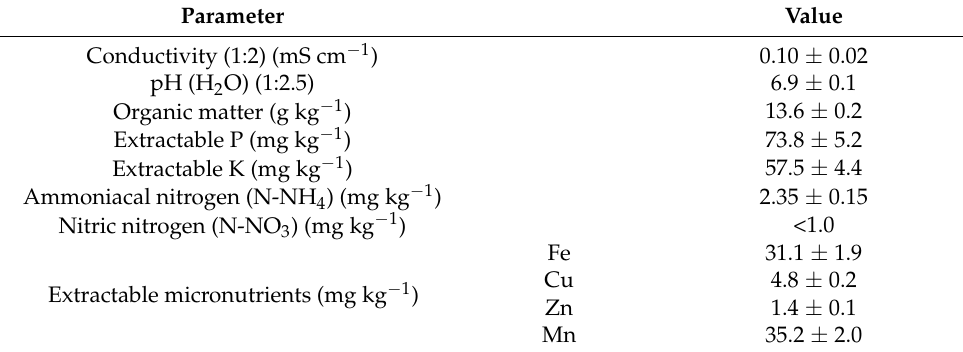
Table 1. Soil characterization.